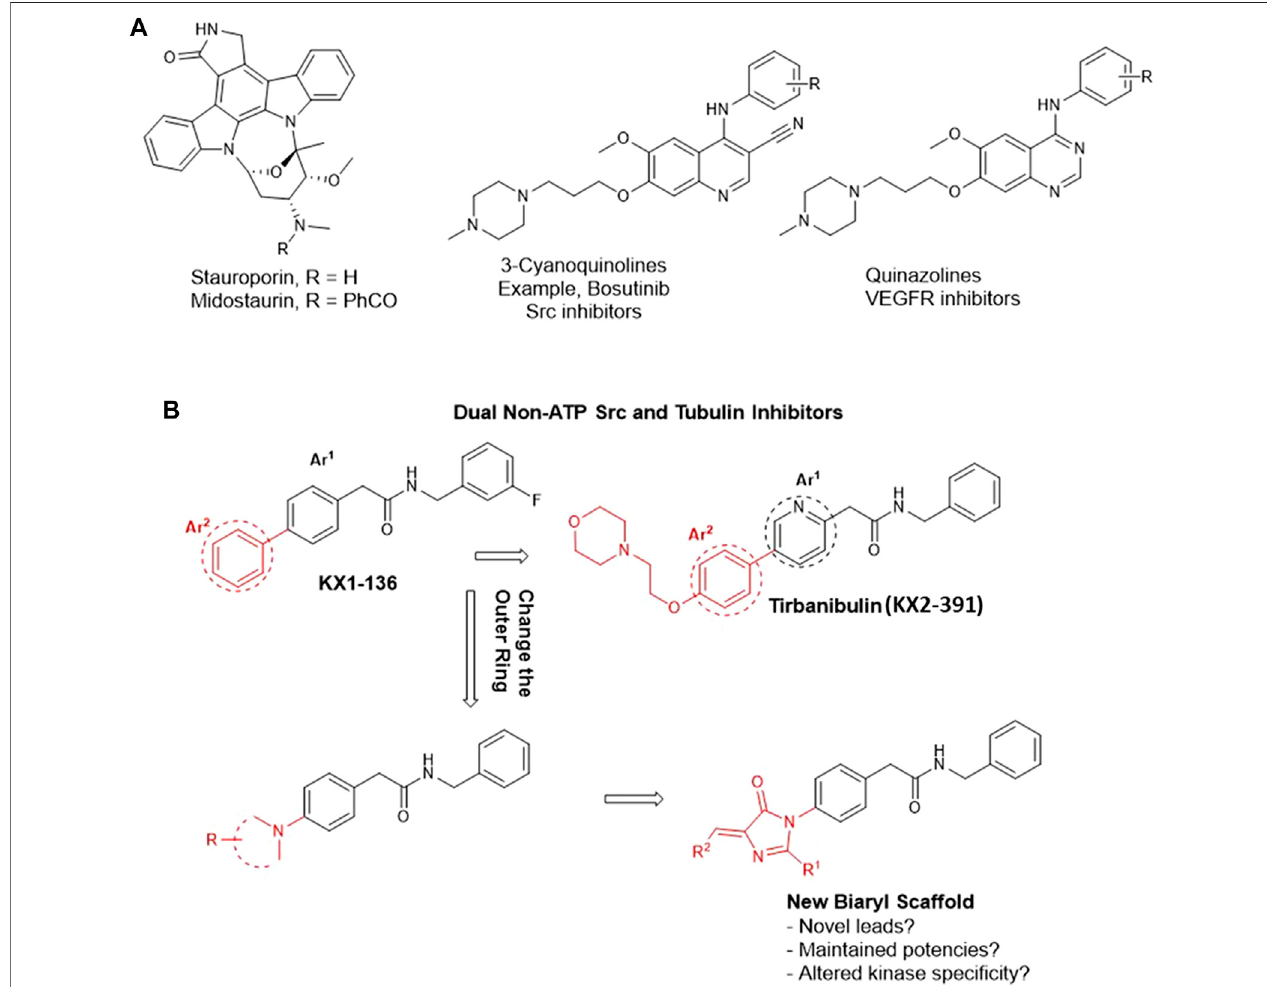
FIGURE 1 | Rational design of imidazolone analogs of KX chemotype. (A) Examples of ATP-competitive kinase inhibitors with altered kinase speci fi city after minor structural changes. Replacing 3-cyanoquinoline with quinazoline caused a shift in kinase inhibition speci fi city from Src to VEGFR. The benzoyl moiety in midostaurin conferredsomespeci fi citytowardmutatedFLT3kinasecompared tothenon-speci fi cstaurosporine. (B) Theblackmotifisconsidereda fi xedpart,common amongthe prototypes (KX1-136 and KX2-391) and the newly designed compounds. The red parts are variables.